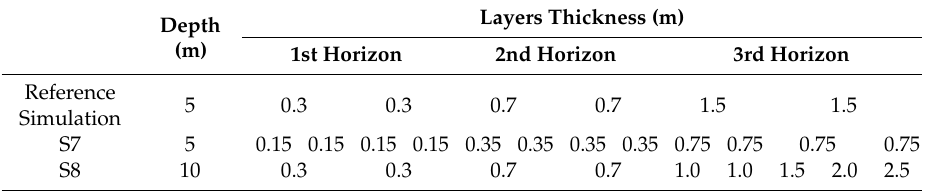
Table 3. Soil discretization for the reference simulation and simulations S7 and